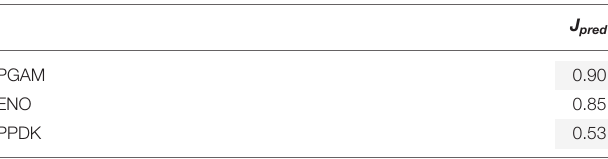
TABLE 2 | Table of mean linear correlations between the enzyme activities and the predicted final flux ( J pred ) for Dataset 1 .